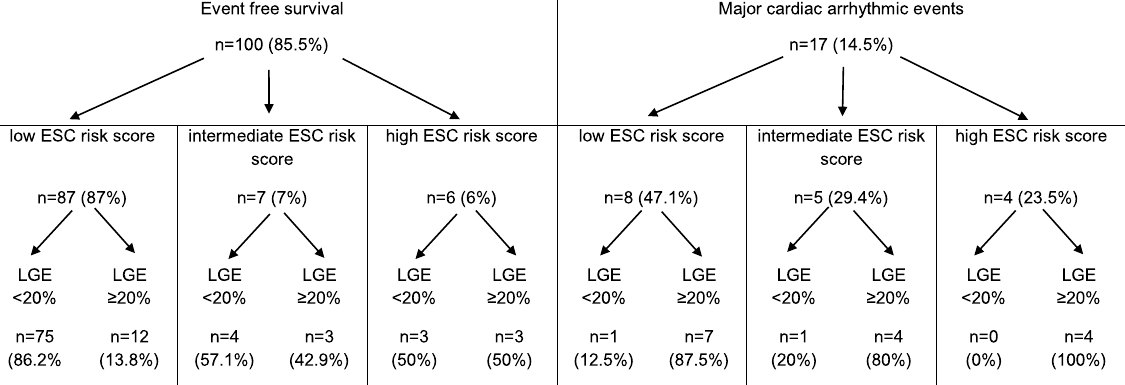
82%). The ROC curve for the probability of SCD according to the ESC risk score revealed an AUC of 0.73 (95%CI 0.59–0.87; p = 0.002 (Fig. 3). The cut-off value for the probability of SCD according to the ESC risk score was 2.6% (sensitivity 71%, specificity 70%). Table 3 illustrates the distribution of patients with major adverse arrhythmic event and event-free patients according to ESC risk score classification in low, interme- diate and high risk patients with HCM. Among the different risk groups, a further subdivision was created depending on the presence of an extent LGE ≥ 20% or < 20%. This data shows that in the group of patients with a low or intermediate ESC risk score ( < 6%) the sensitivity of an extent LGE ≥ 20% to predict a major adverse arrhythmic event is 84.6%. The ability of extent LGE ≥ 20% for further risk stratification in the low and intermediate ESC risk group is further underlined by the significant higher event-rate in the group of HCM patients with an extent LGE ≥ 20% compared to HCM patients with an extent LGE % below the cut-off in Kaplan–Meier survival analysis (Fig. 4) (Log-rank, p < 0.0001). In the group of patients with an ESC risk < 6% and an extent LGE ≥ 20% (n = 26), 11 major adverse cardiac arrhythmic events occurred during the follow-up period resulting in an annual event rate of 10.5% in these patients (Table 3). In patients with a high ESC risk score ≥ 6% none of the patients with an extent LGE < 20% suffered from a major adverse arrhythmic event (Table 3). Therefore, an extent LGE < 20% exhibits a negative predictive value of 100% in the ESC high risk group.